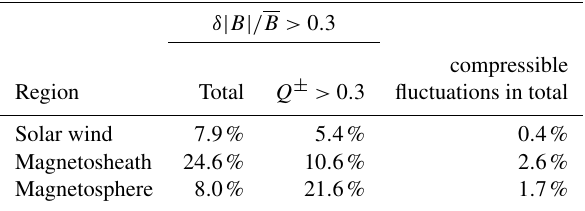
Table 1. The first column gives the percentage of the sub-intervals where the magnetic field magnitude fluctuations, δ | B | /B , are larger than 0.3 in each respective region. The percentage in the second col- umn shows how many intervals of the sub-intervals with δ | B | /B > 0 . 3 are dominated by compressional fluctuations ( Q ± > 0 . 3). The last column reflects the percentage of compressional fluctuations MESSENGER observes in total in each region. δ | B | /B > 0 . 3 compressible Region Total Q ± > 0 . 3 fluctuations in total Solar wind 7 . 9% 5 . 4% 0 . 4% 2 . 6% 1 .